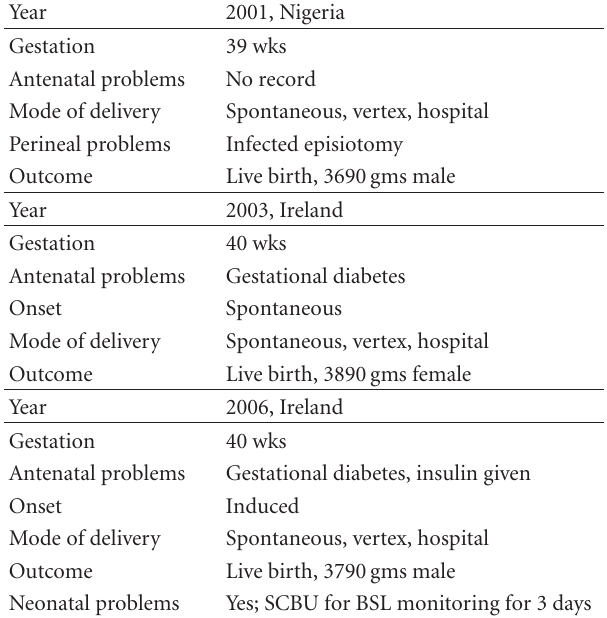
Table 2: Record of previous